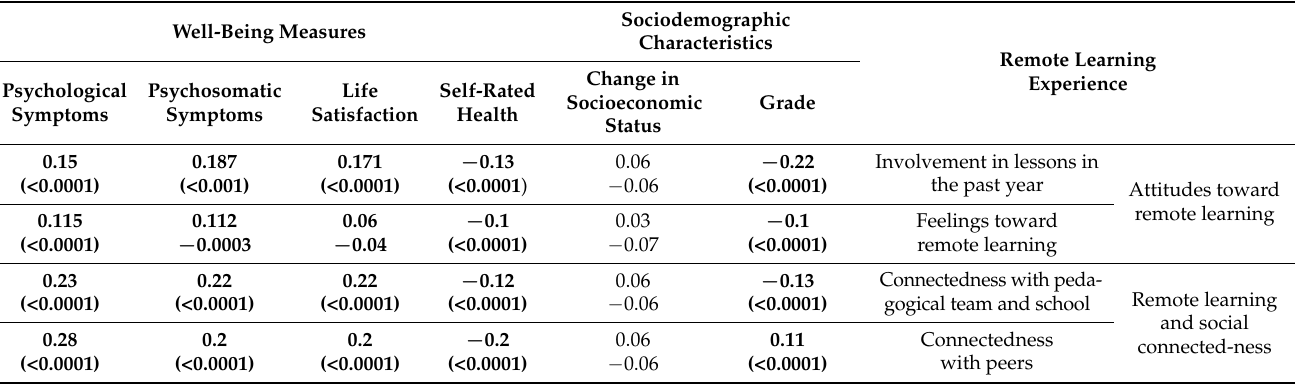
Table 5. Associations of participants’ remote learning experience with sociodemographic characteris- tics and well-being ( n = 1019).